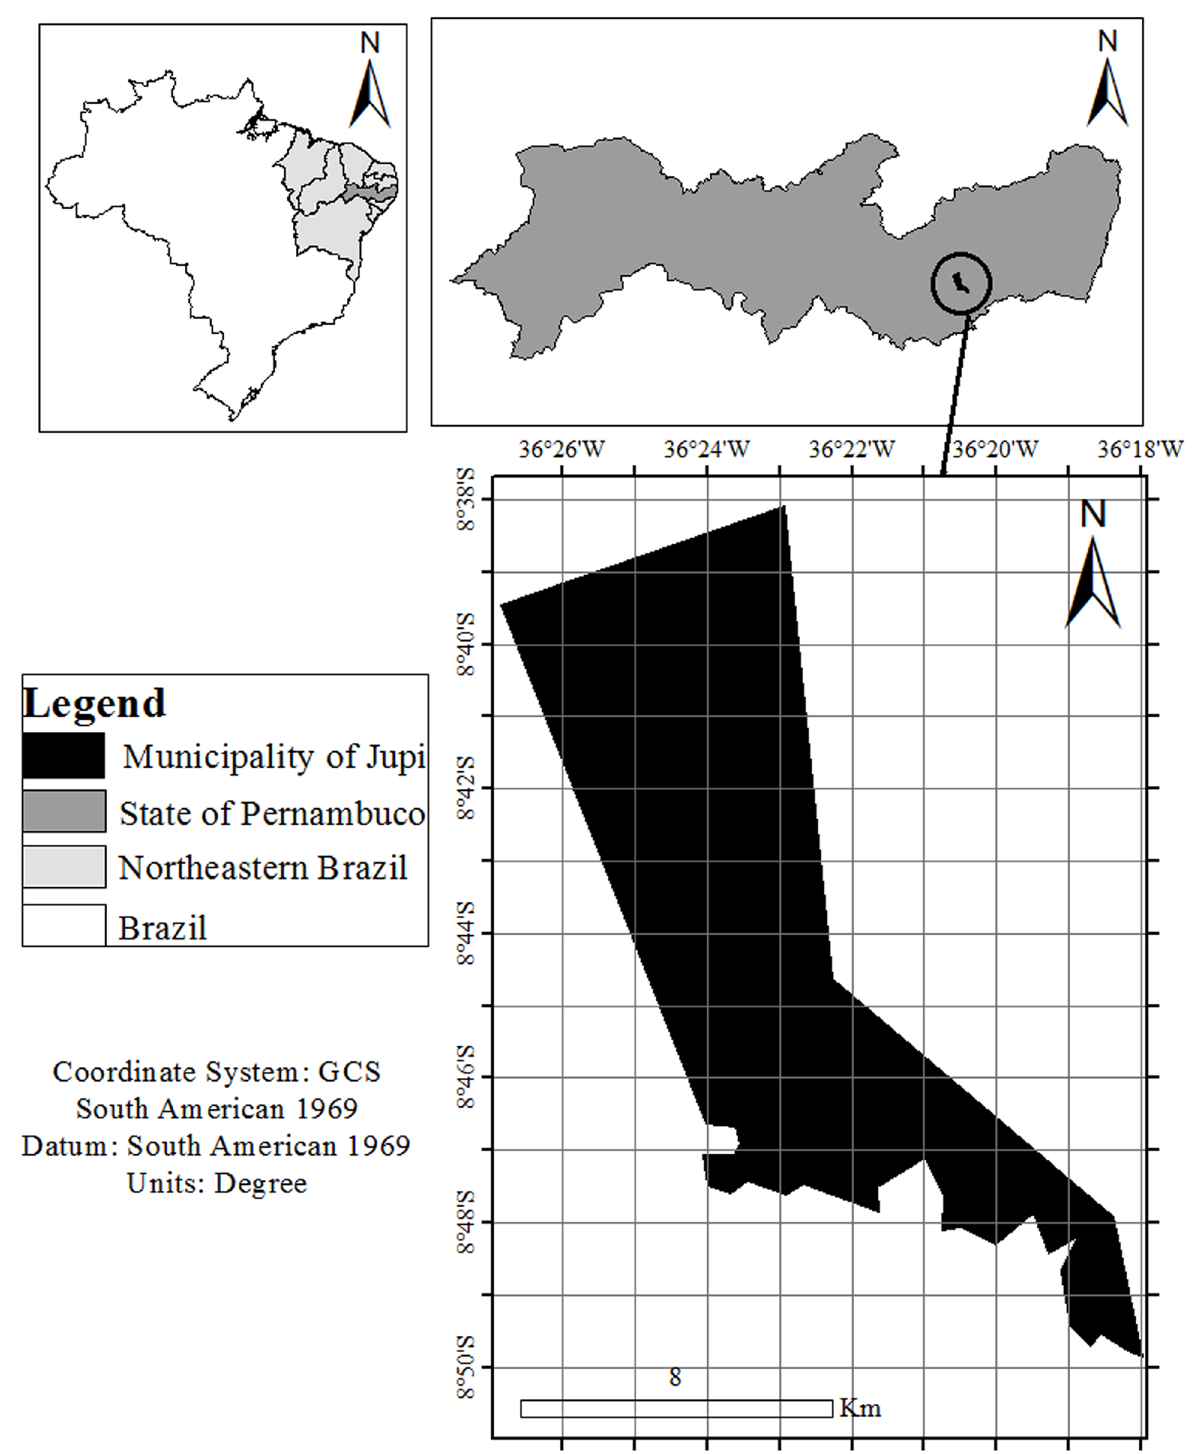
Fig 1. Location of the municipality of Jupi in Pernambuco, Brazil. Black — Municipality of Jupi; Dark Gray — State of Pernambuco; Light Gray — Northeastern Brazil; White — Brazil.